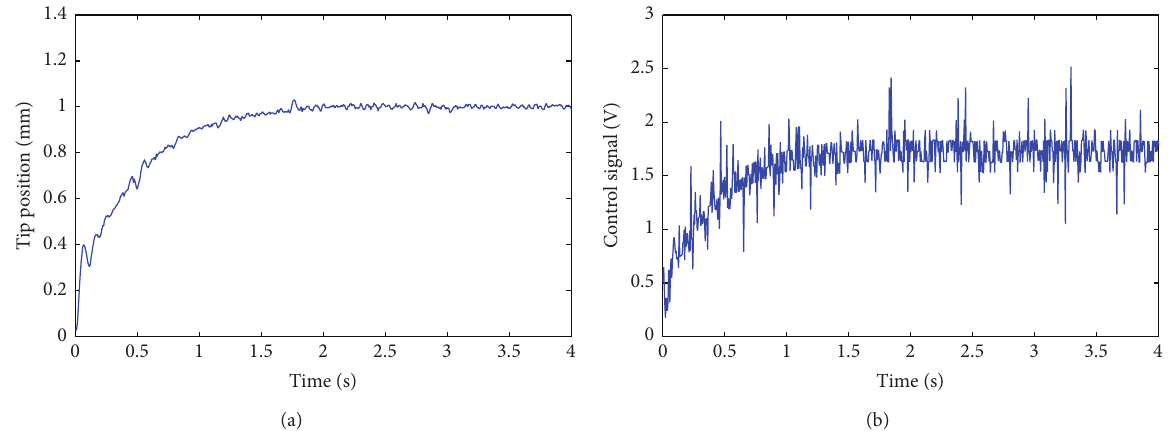
Figure 11: Step response of the closed-loop experimental system with the fractional-order controller: (a) tip position, (b) control signal.